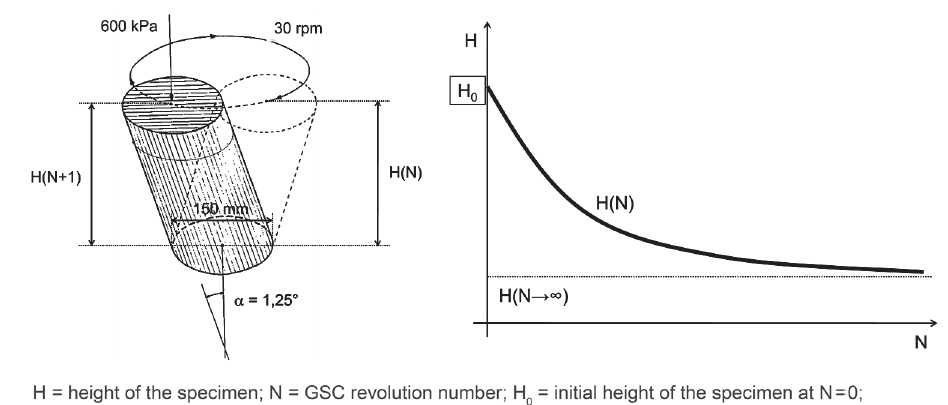
Fig. 2. Illustration of the gyratory shear compaction and diagram of the compaction process